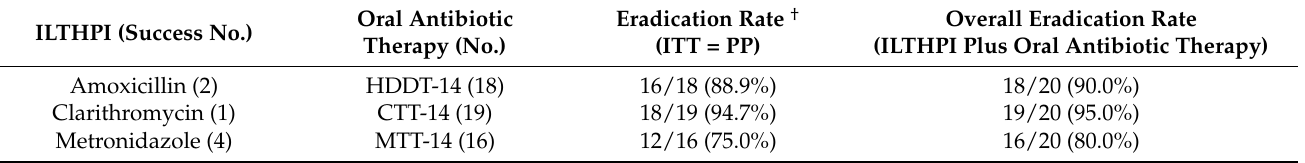
Table 4. The overall eradication rate of intraluminal therapy plus oral antibiotic therapy.